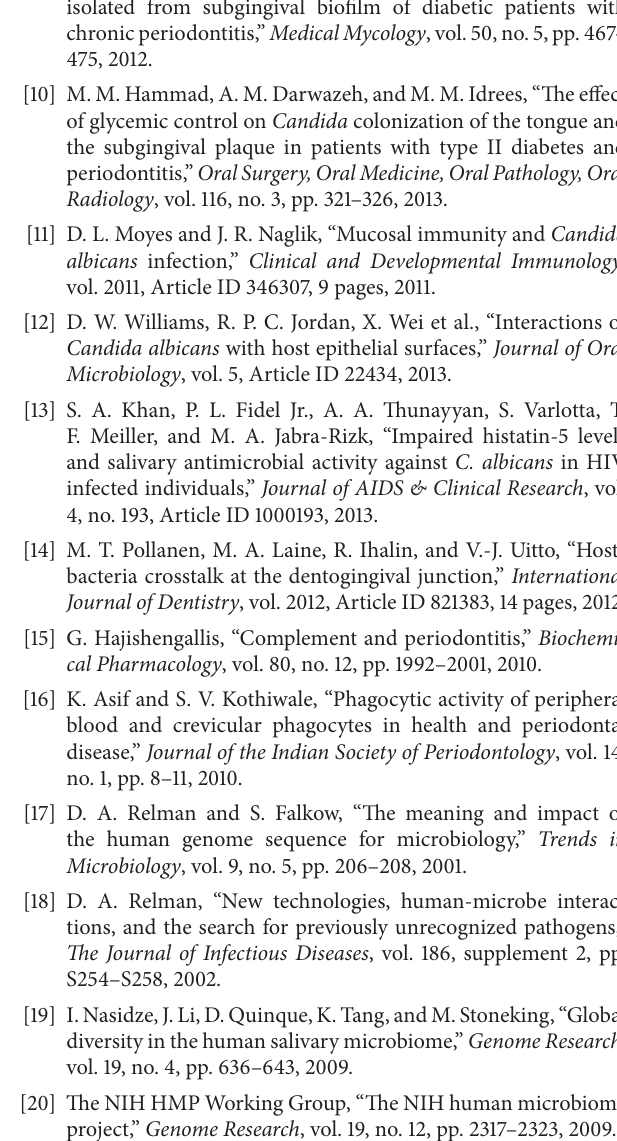
in the shift into a disease state though the symptoms of the disease are not always